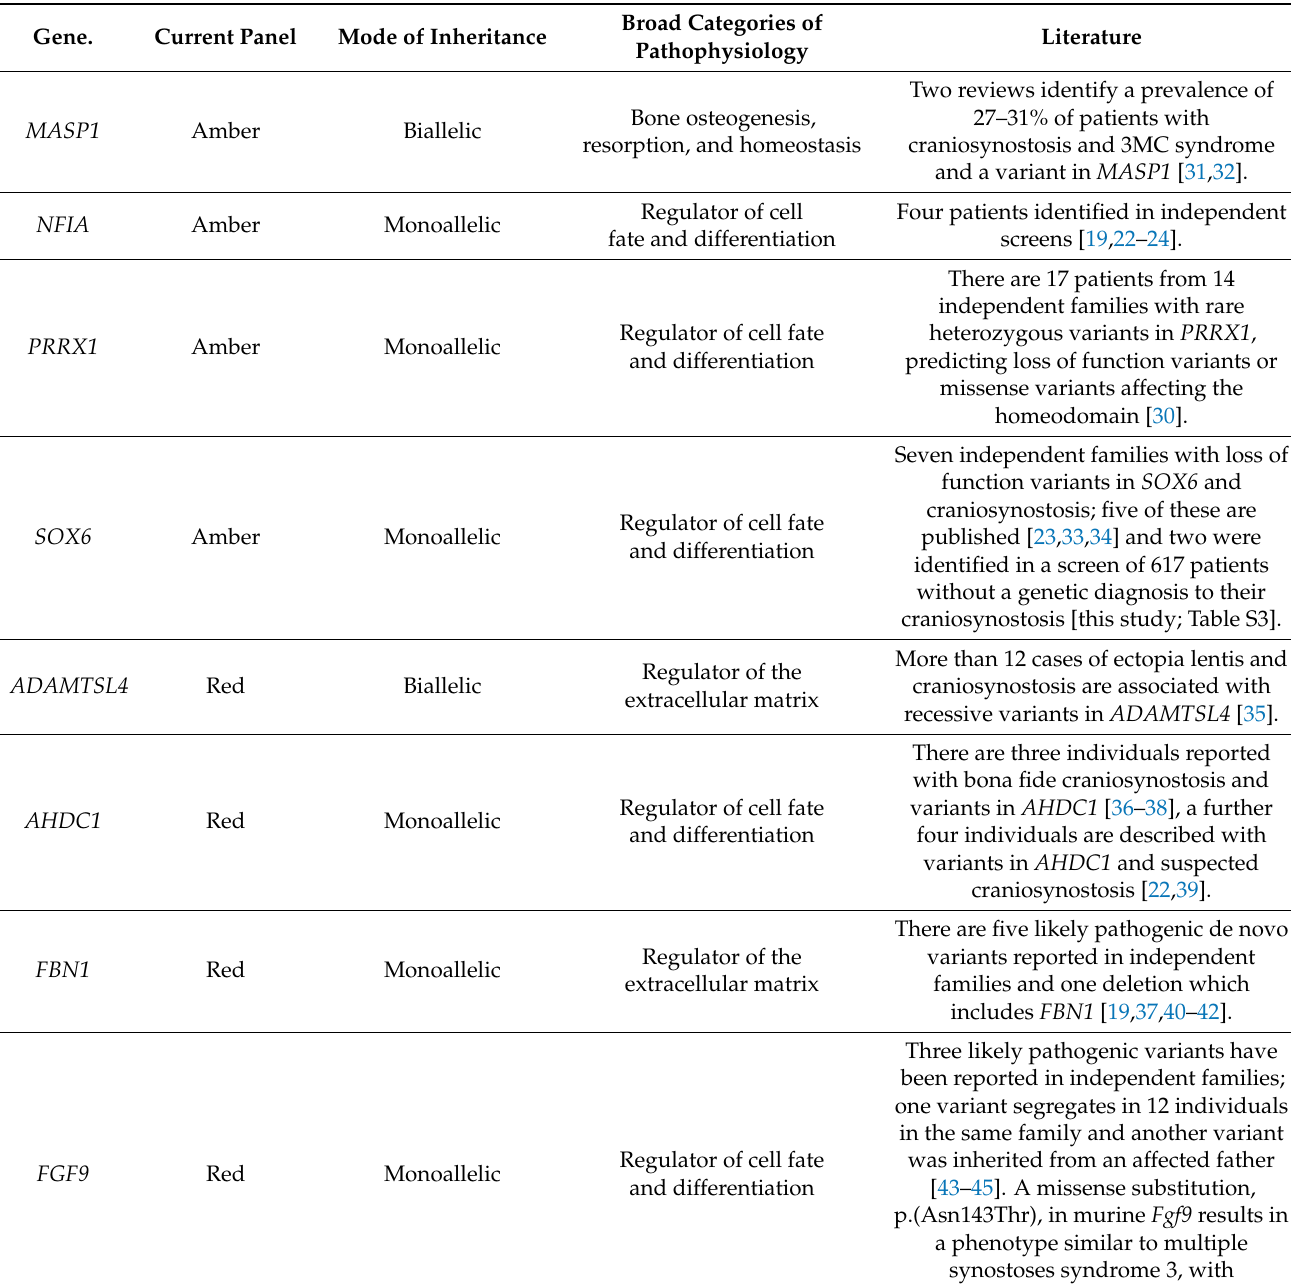
Table 2. Genes with sufficient evidence to be updated to Green PanelApp